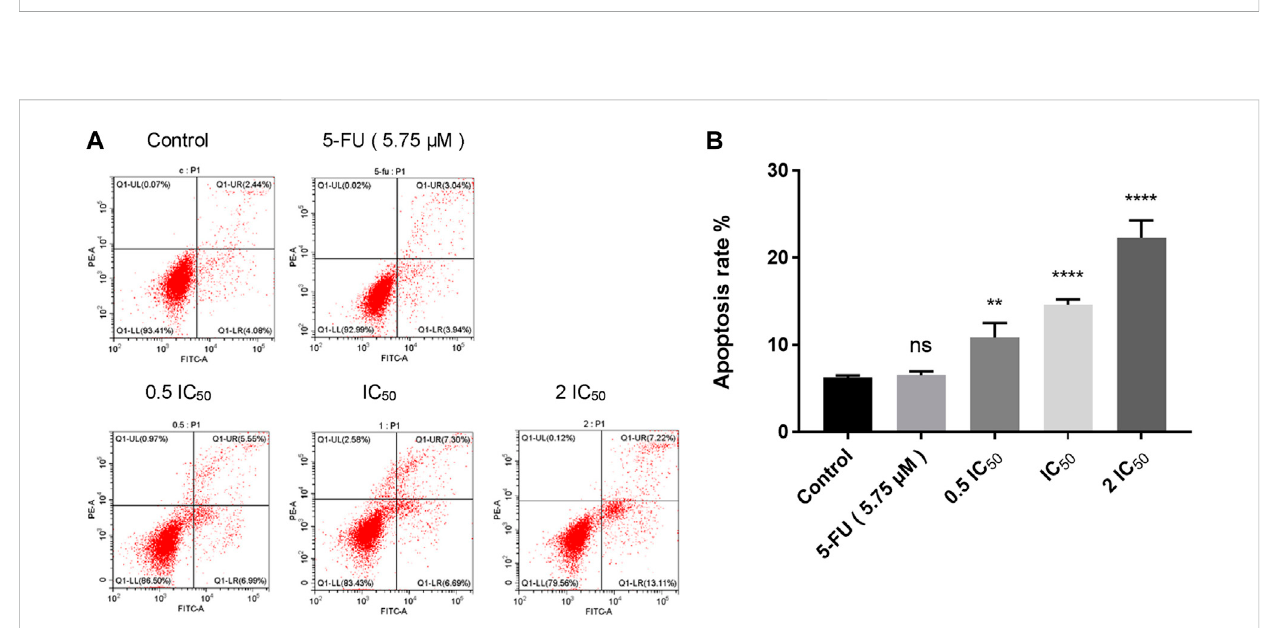
FIGURE 5 Compound 6e induced apoptosis of KB cells. (A) Dot plot depicting KB cells treated with compound 6e . (B) Quanti fi cation of the cell apoptosis results ( n = 3). **** ( p < 0.0001), *** ( p < 0.001), ** ( p < 0.01), * ( p < 0.05), ns (not signi fi cant).